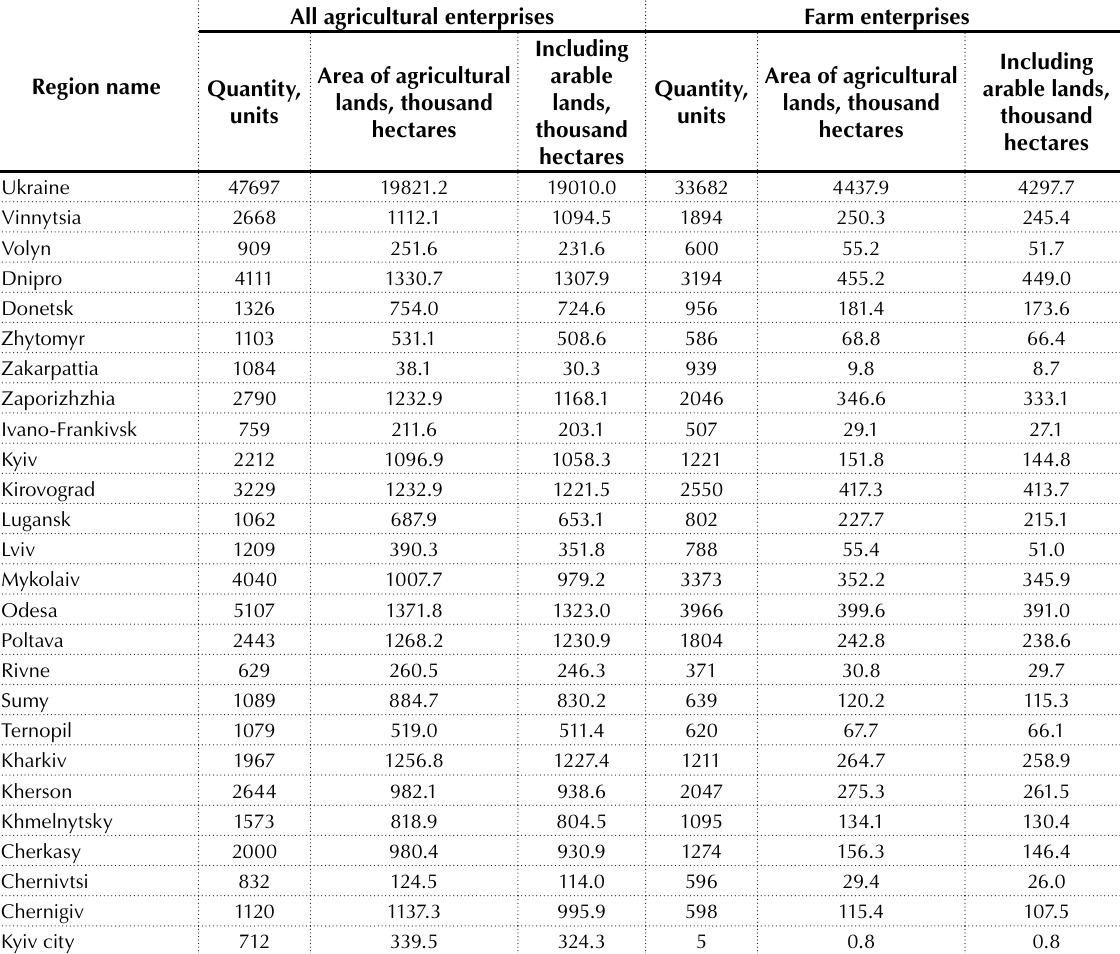
Table 2. Number of agricultural enterprises in Ukraine and the area of agricultural lands in their use by regions 1,